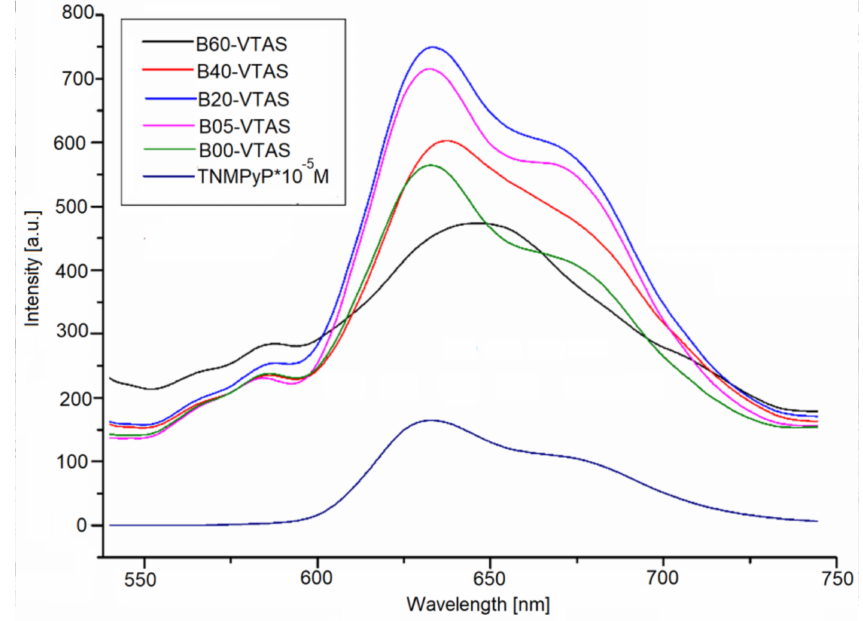
Figure 13. Emission spectra of the sol-gel immobilized Zn-TNMPyP using different vinyl substituted silica